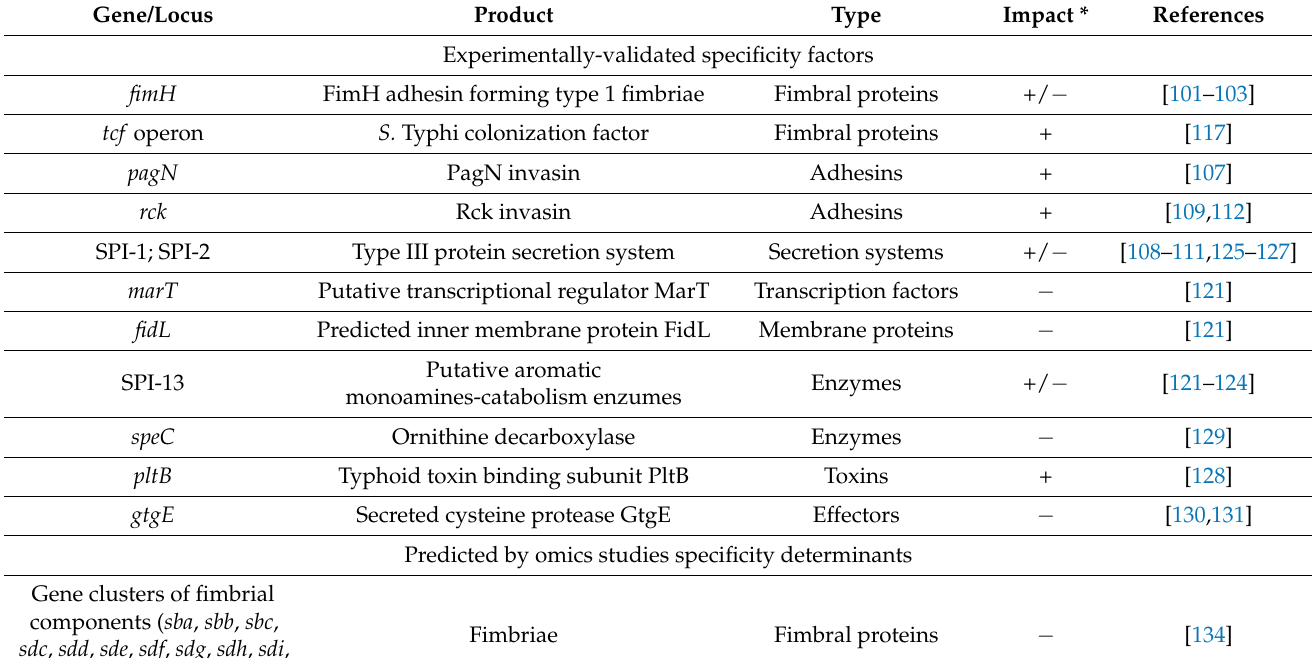
Table 3. Putative and experimentally detected specificity factors of Salmonella